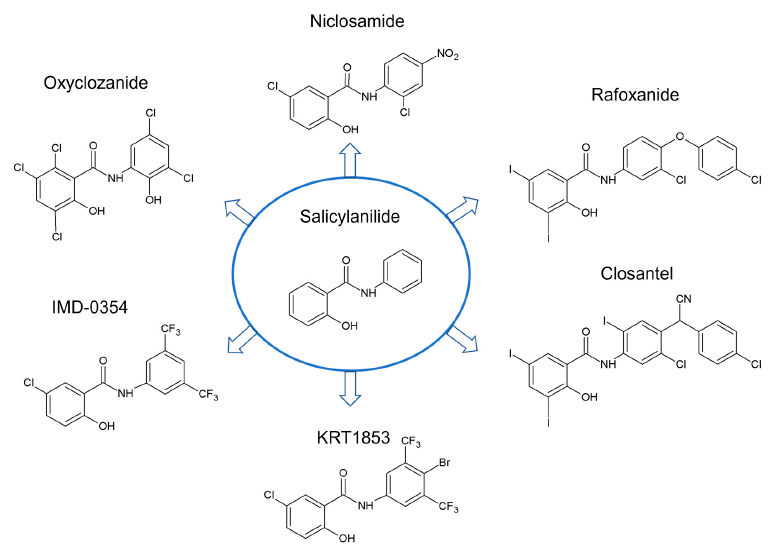
Figure 1. Structures of salicylanilides investigated for their potential anticancer properties.